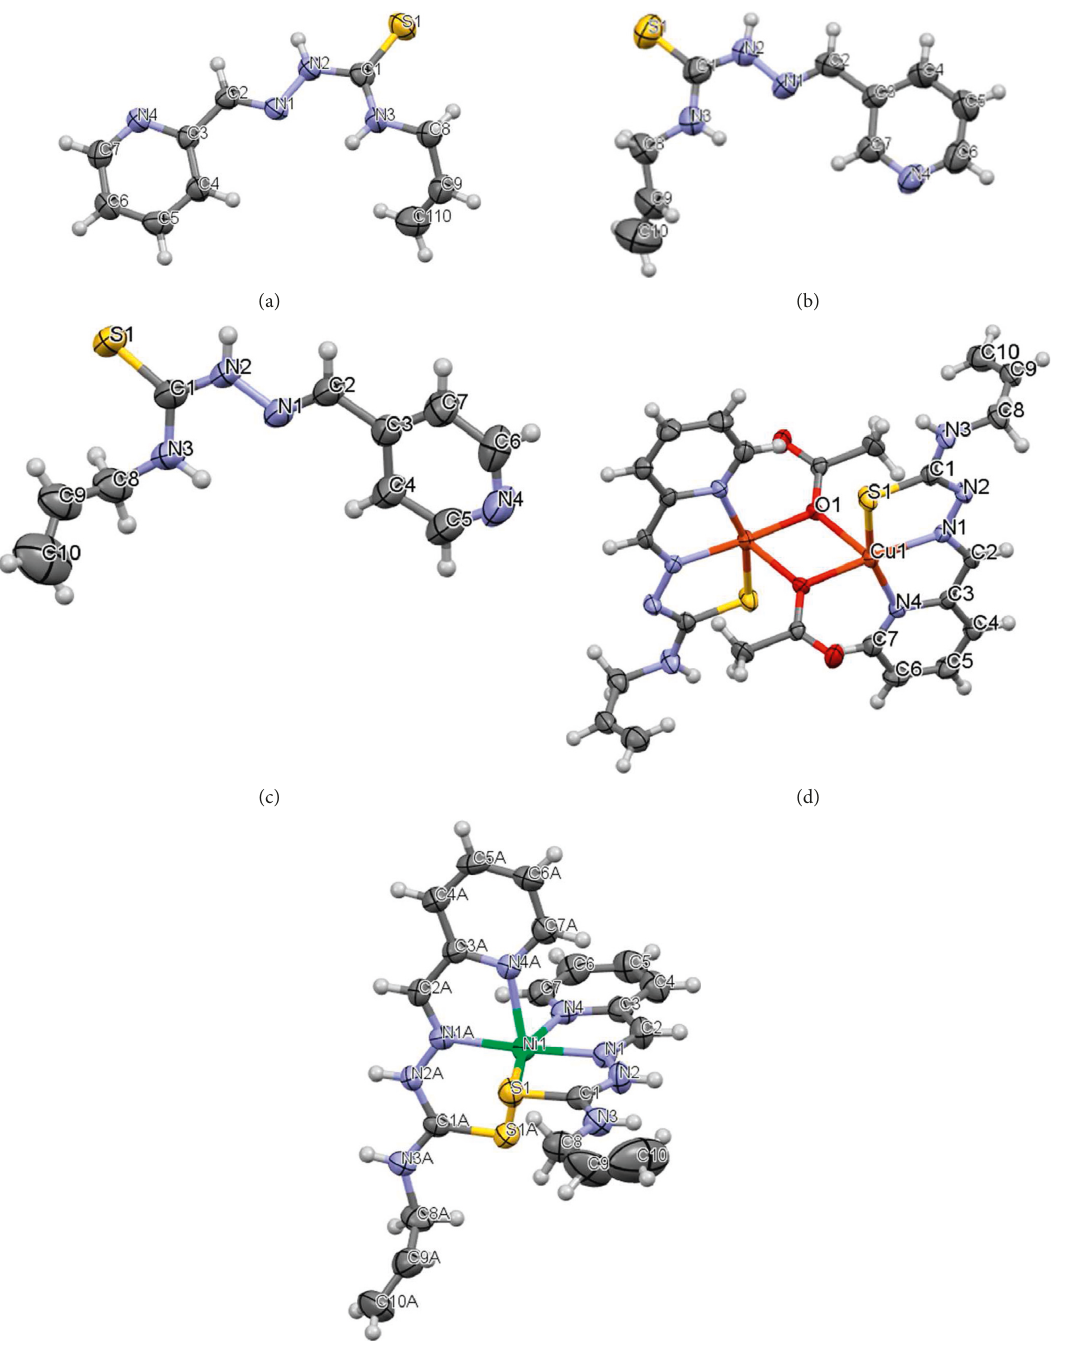
Figure 1: View of (a) HL , (b) HL a , (c) HL b , (d) 4 , and (e) 5 compounds with atom numbering. Thermal ellipsoids are drawn at 50% probability